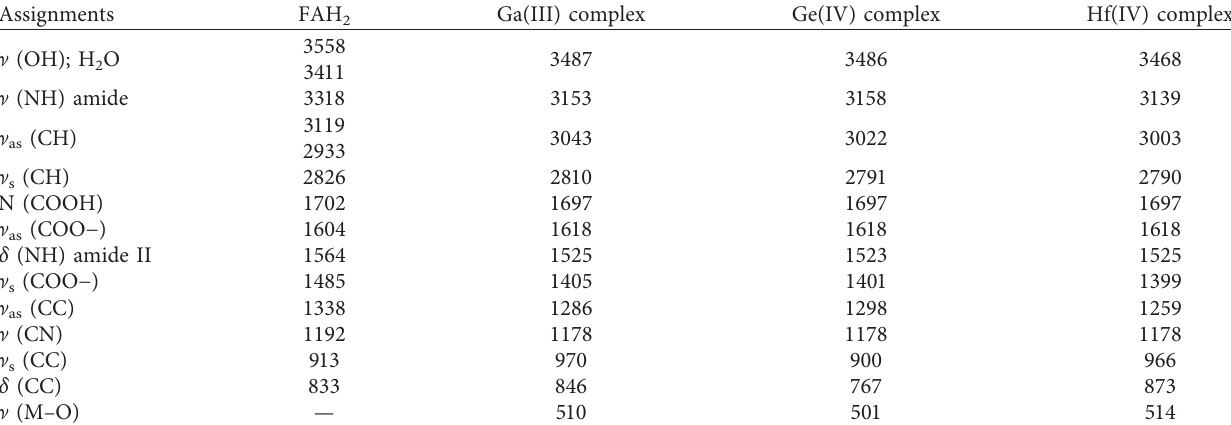
2 and synthesized complexes.